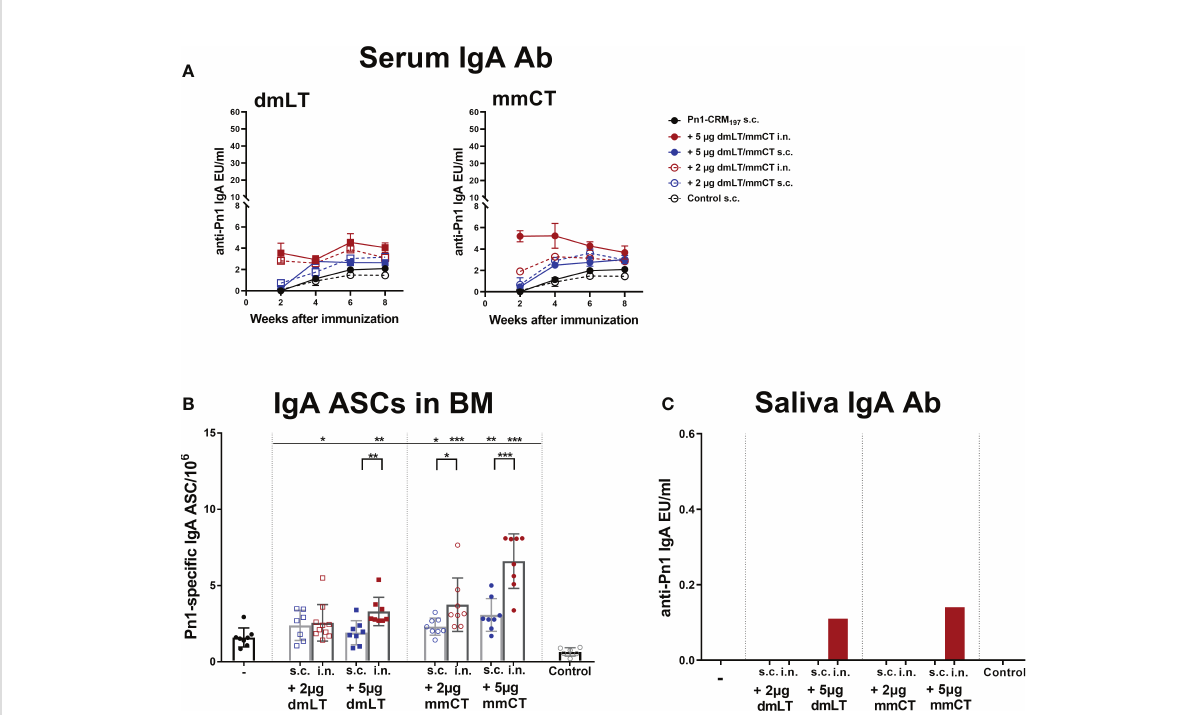
FIGURE 2 Intranasal immunization of neonates with adjuvants dmLT and mmCT enhance both systemic and mucosal IgA responses. Pn1-speci fi c serum IgA Ab levels 2, 4, 6 and 8 weeks (A) and number of of Pn1-speci fi c IgA + AbSCs in bone marrow (B) 9 weeks after s.c. or i.n. immunization of neonatal mice with Pn1-CRM 197 with or without 2µg or 5µg of adjuvants dmLT or mmCT. Results are expressed as IgA levels (EU/ml ± SEM) in 3 comparable independent experiments combined and as number of spots/10 6 cells (mean ± SD) in 7 – 8 mice per group. Saliva was collected 8 weeks after immunization and Pn1-speci fi c IgA Abs were measured in saliva samples by ELISA (C) . Statistical difference was calculated using Mann – Whitney U-test where adjuvant groups were compared to vaccine only group and immunization routes were compared between the adjuvanted groups. *p ≤ 0.05, **p ≤ 0.01, ***p ≤